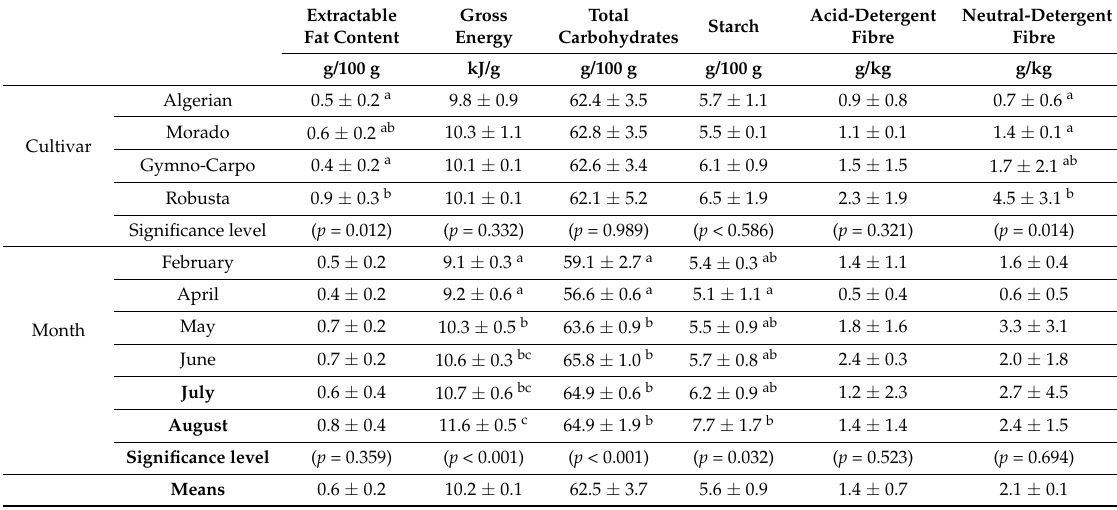
Table 1. Fat, gross energy, carbohydrate, starch and detergent fibre content of freeze-dried mucilage powders extracted from four cactus pear cultivars harvested from cladodes over six months. Extractable Fat